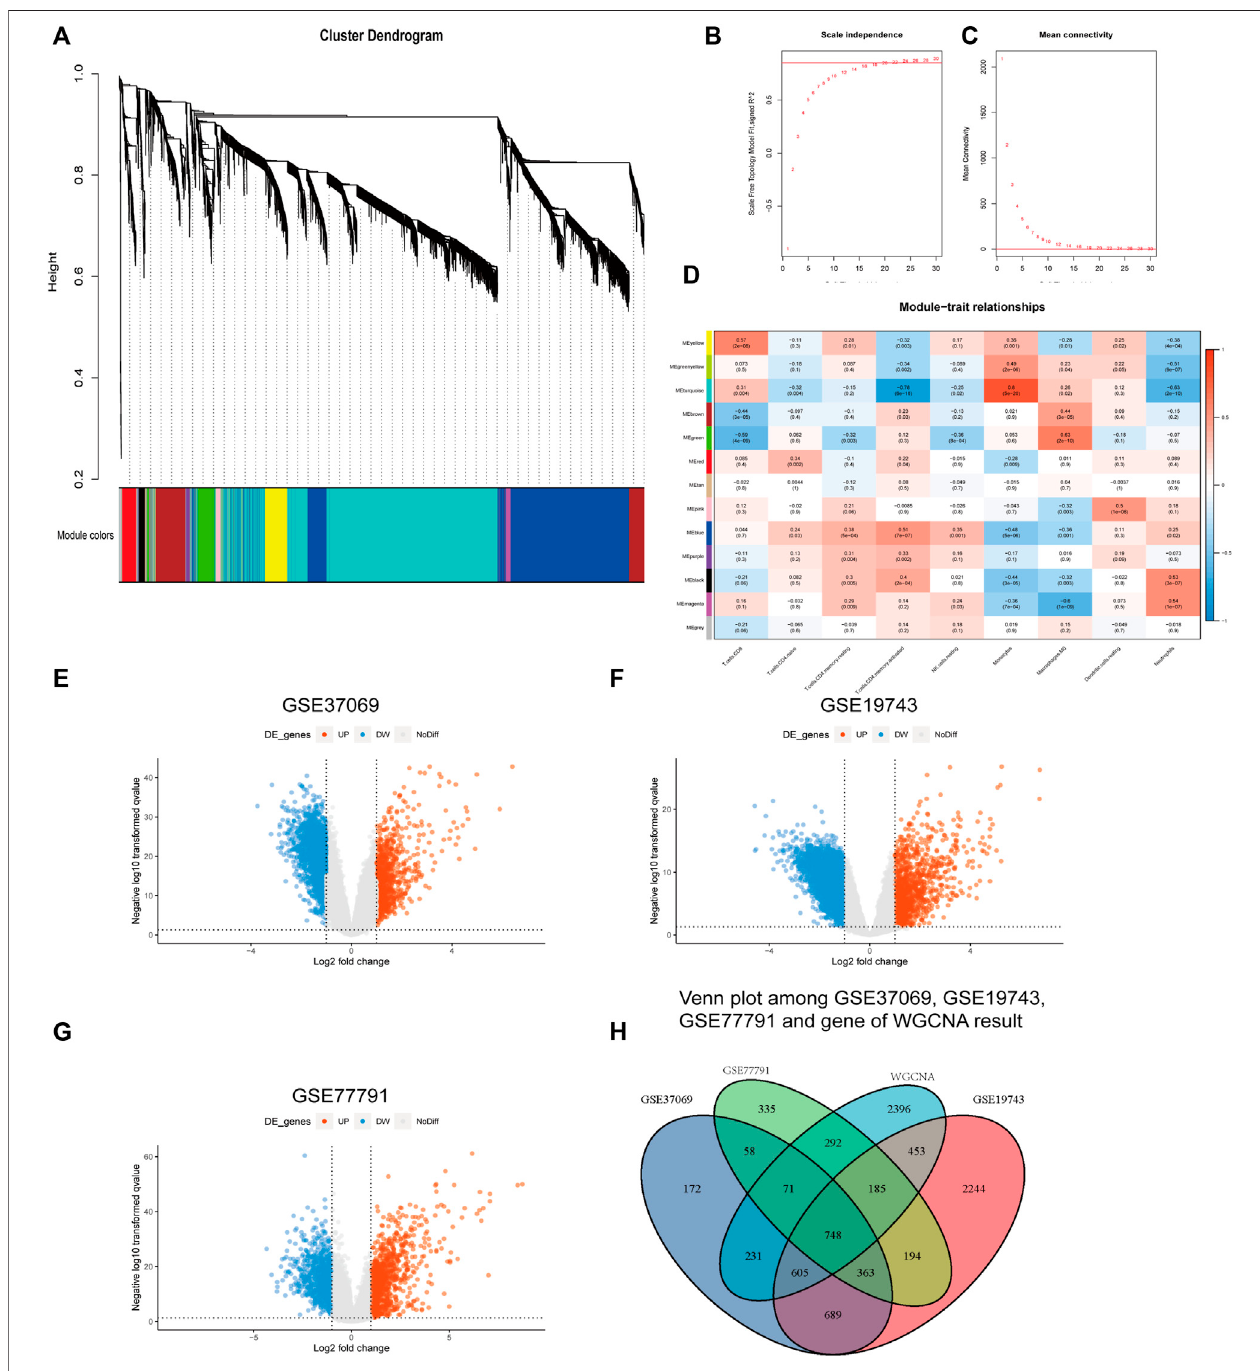
FIGURE4| ResultsofWGCNAanddifferentexpressionanalysis. (A) GenesinGSE37069weredividedinto12modulesindifferentcolors.Genesinthesamecolor modulehavesimilar expressionpatterns. (B,C) Softpower ofWGCNA. (D) Correlation genesandimmune cells.Theordinateisthegenemodule; theabscissaisthecell type. Blue are negative correlations and red are positive correlations. (E – G) The ordinate is the -log 10 p value; the abscissa is the logFC. (H) Intersection of genes in GSE19743, GSE37069, GSE77791, and immune cell-related genes in WGCNA.